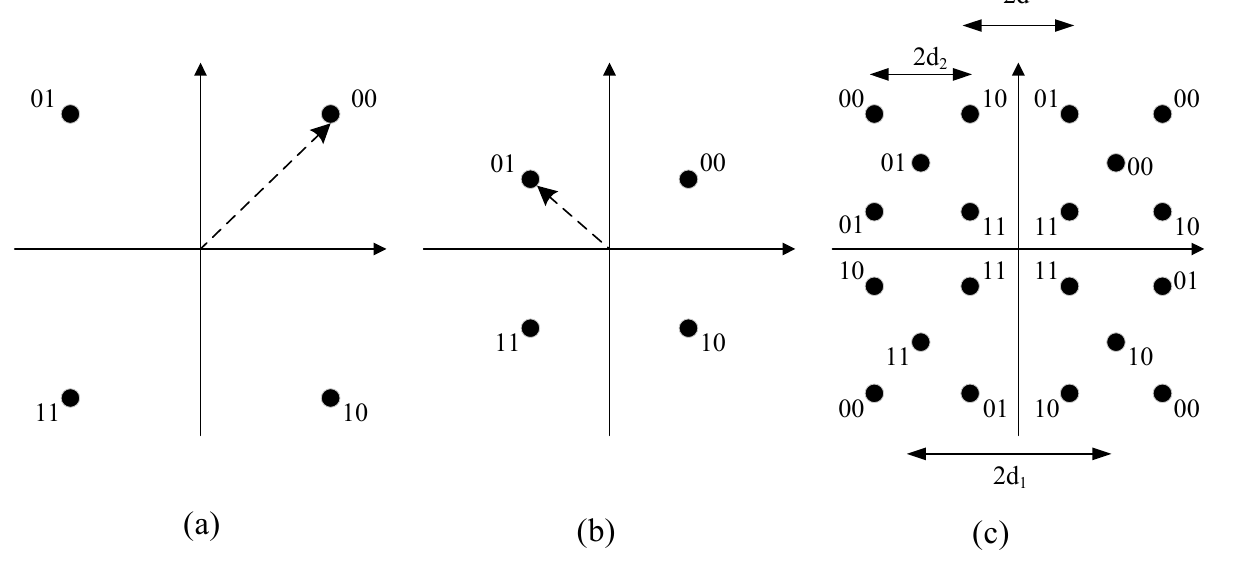
Figure 2. Constellation of 4/16-QAM hierarchical modulation.